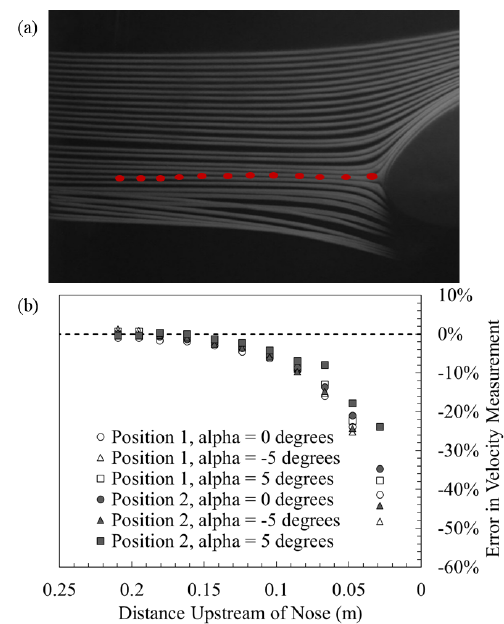
Figure 3. Results of investigation of airframe influence on flow field: ( a ) scale-model flow visualization, and ( b ) full-scale wind tunnel comparison of measured velocity to true velocity. Red dots in ( a ) correspond to streamwise measurement locations in ( b